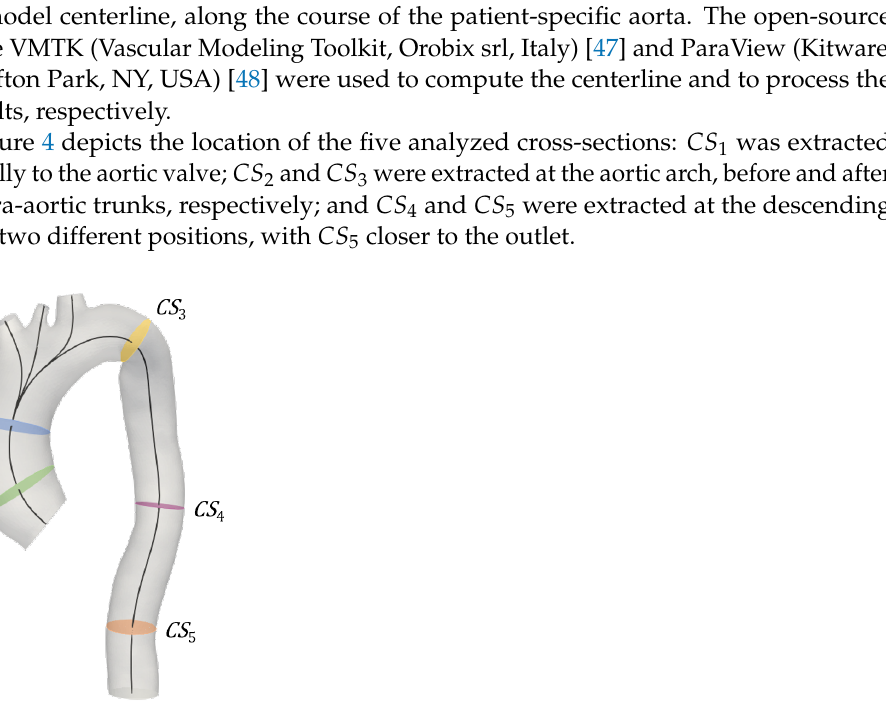
Figure 4. Location of the cross-sections extracted from the FSI simulations, perpendicular to the model centerline: CS 1 (green) proximal to inlet valve; CS 2 (blue) at the ascending aorta; CS 3 (yellow) after supra-aortic branches; and CS 4 (pink) and CS 5 (orange) at the descending aorta, with this latter closer to the outlet